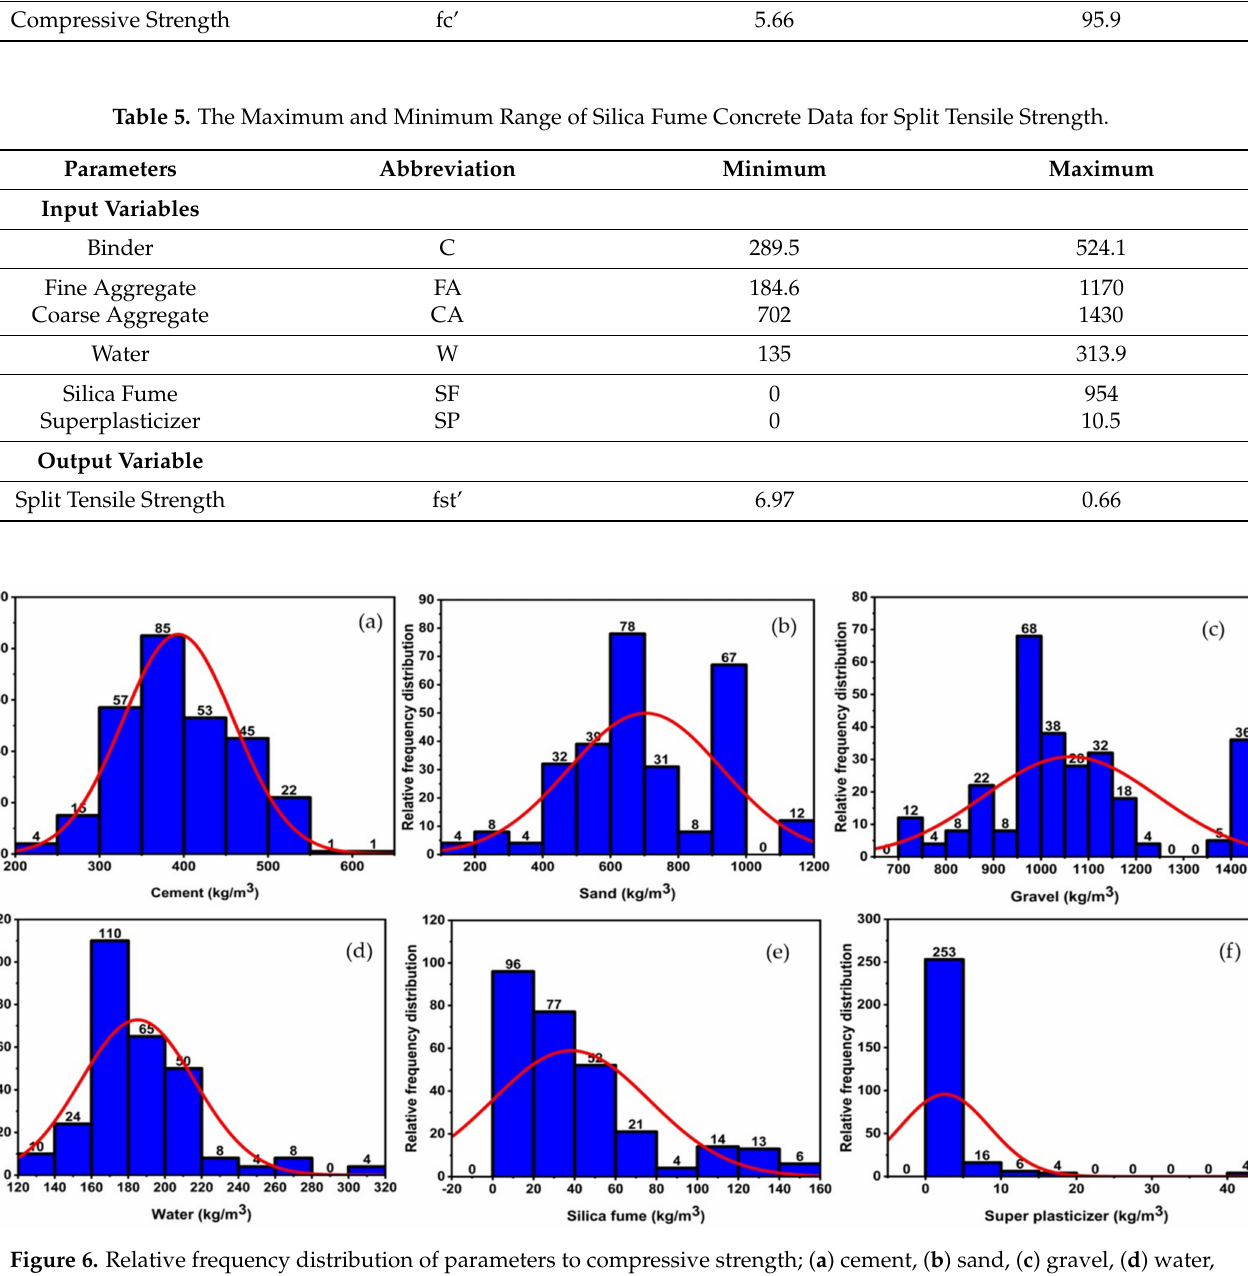
Figure 6. Relative frequency distribution of parameters to compressive strength; ( a ) cement, ( b ) sand, ( c ) gravel, ( d ) water, ( e ) silica fume, ( f ) super